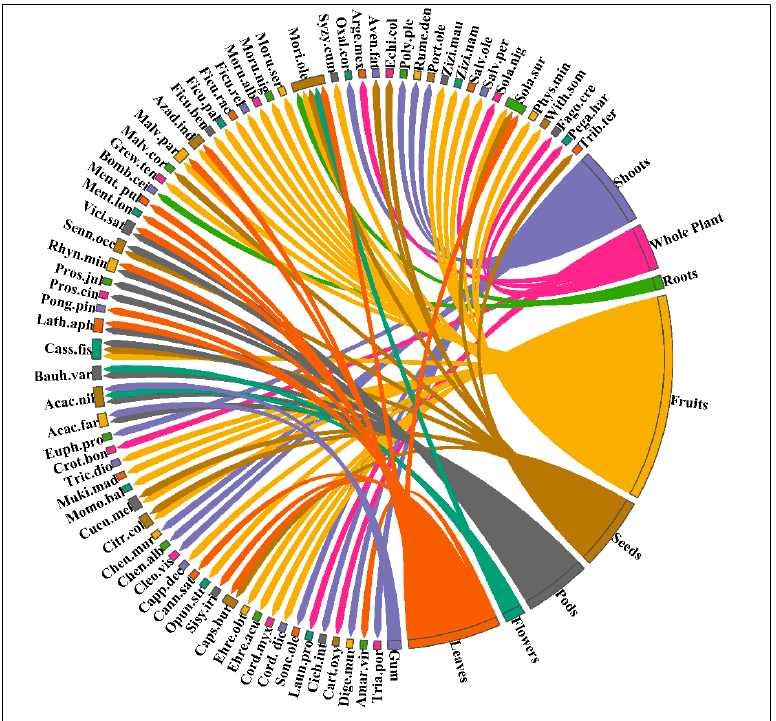
Figure 4. Chord diagram depicting the plant parts used and species name as WFPs.